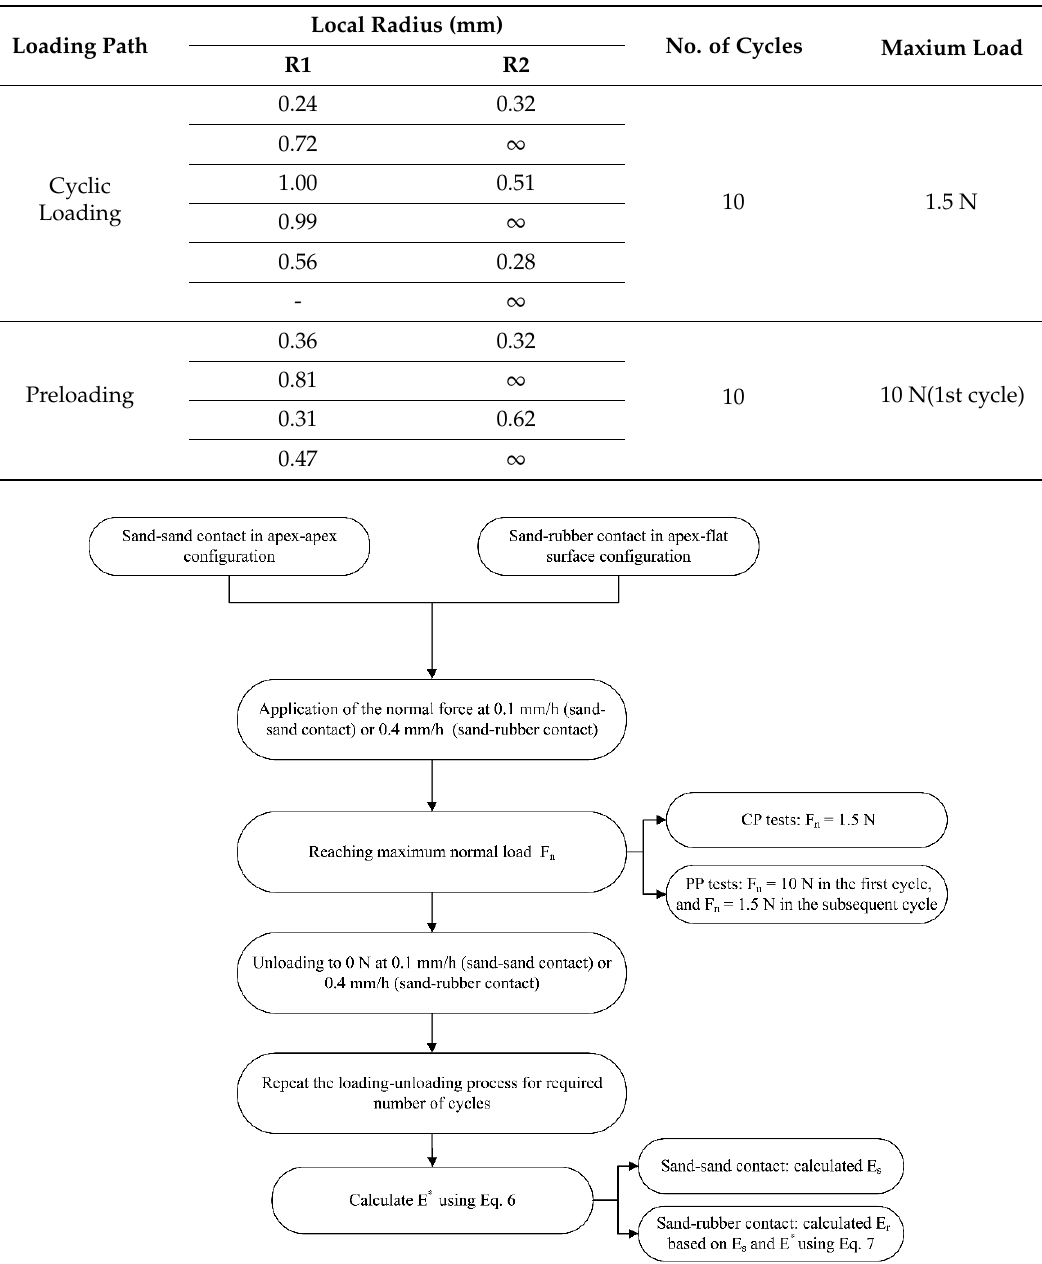
Table 1. Summary of the testing program and particle geometry parameters.